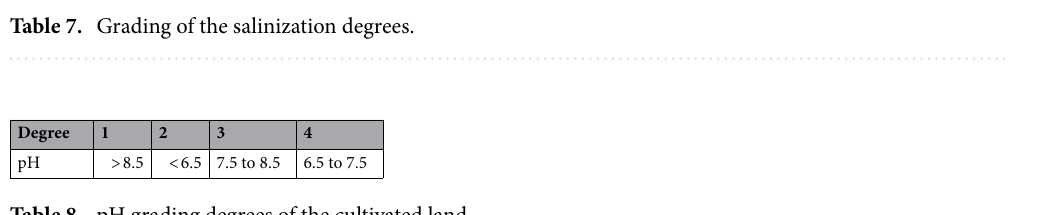
Table 8. pH grading degrees of the cultivated